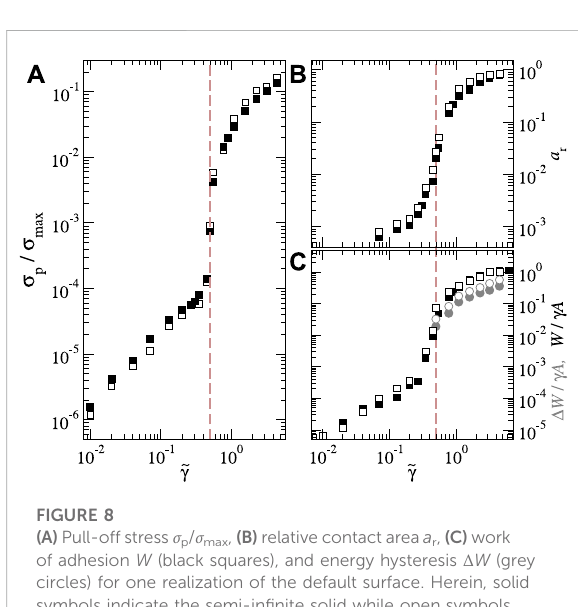
FIGURE 8 σ (B) relativecontact area a (C) work (A) Pull-off stress σ p / max , r , of adhesion W (black squares), and energy hysteresis Δ W (grey circles) for one realization of the default surface. Herein, solid symbols indicate the semi-in fi nite solid while open symbols refer to a thin sheet with a thickness of t = 1/(2 q r